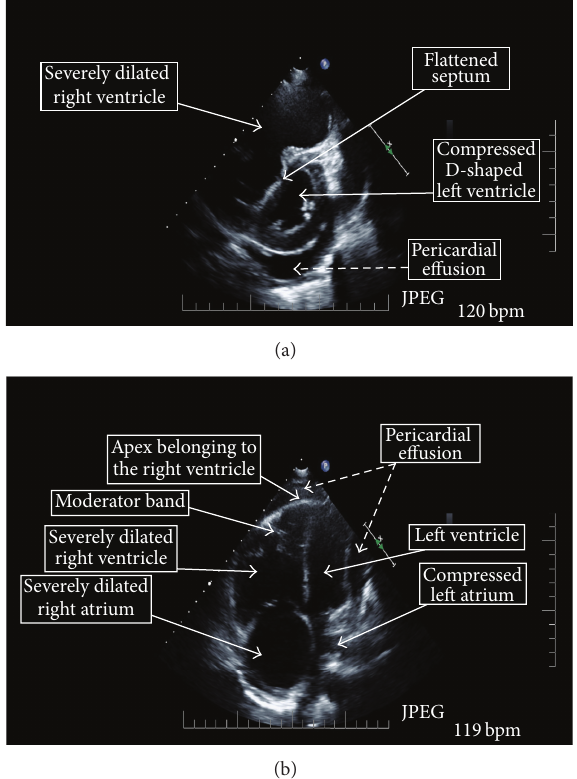
Figure 1: Echocardiogram of the patient demonstrating key features of severe pulmonary arterial hypertension. (a) Left parasternal short axis view. (b) Four-chamber apical view. Elevated pulmonary artery systolic pressures lead to a dilated right ventricle and right atrium. Dilation of the right ventricle causes flattening of the interven- tricular septum and the normally larger left ventricle becomes constricted. The rapid heart rate of 120bpm also reduces the time for left ventricular filling and coronary artery perfusion. All of this resultsinhemodynamiccompromisewithdecreasedcardiacoutput, which can result in cardiogenic